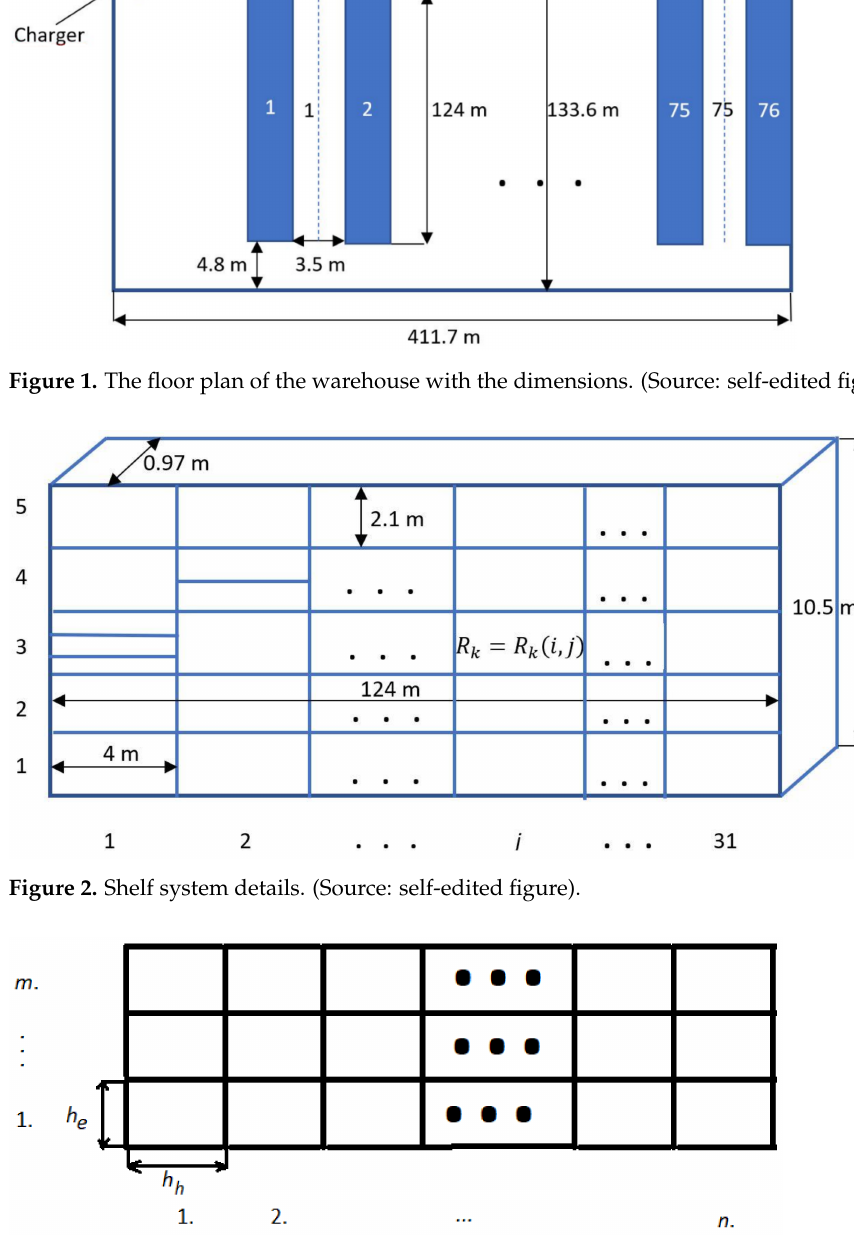
Figure 3. Structure of a shelf. (Source: self-edited